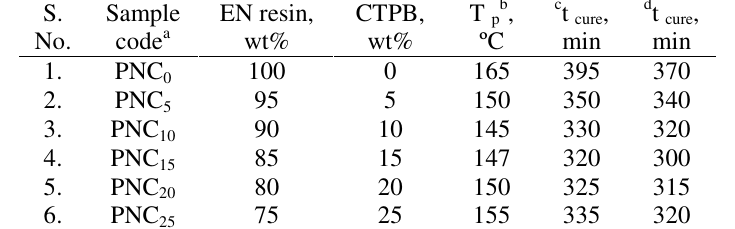
Table 1. Variation of cure time for the blend samples cured with polyamide at 150 °C.